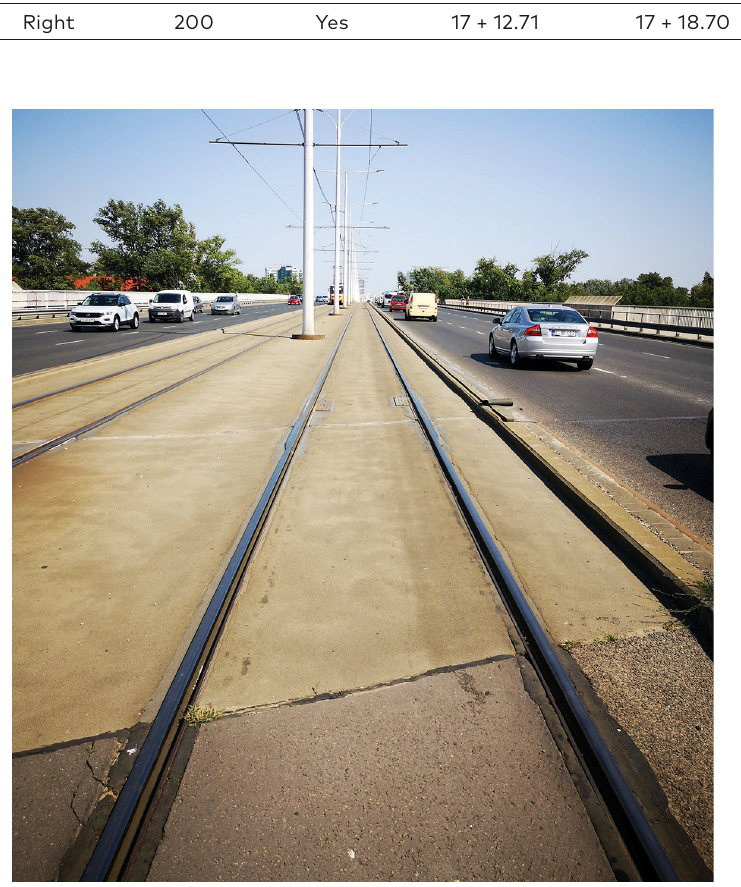
Figure 13. Section 4, 2021 (authors’